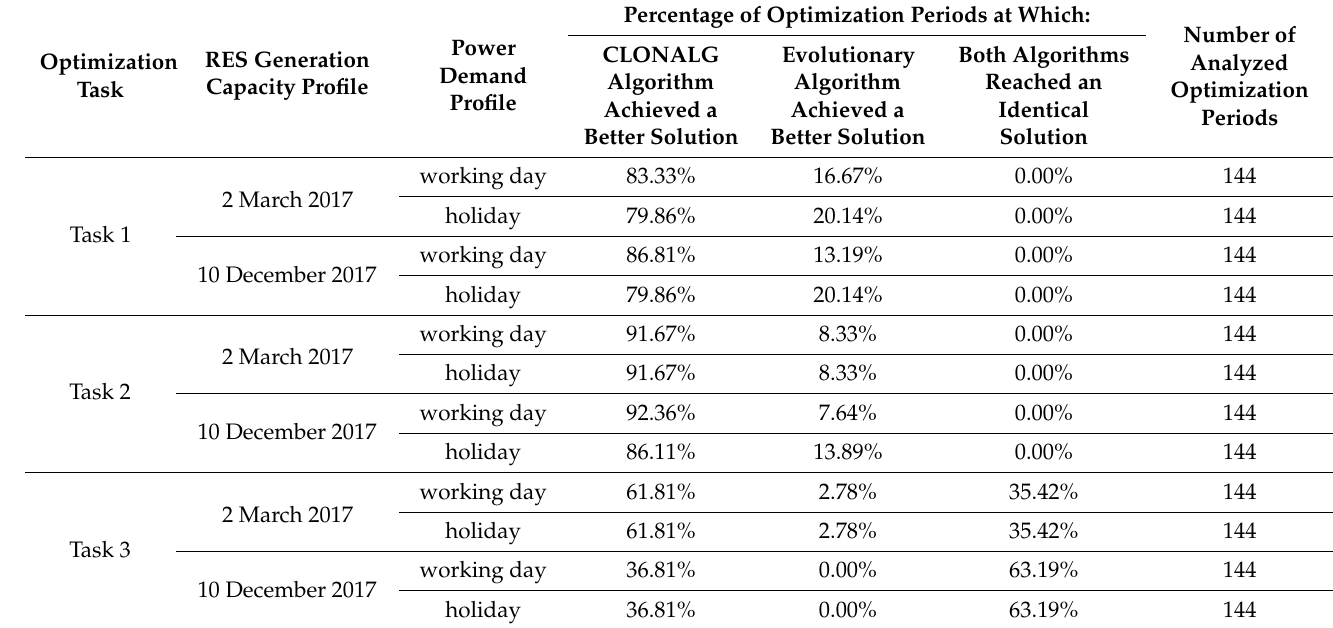
Table 7. Comparison of results of optimization calculations for the microgrid synchronous operation.